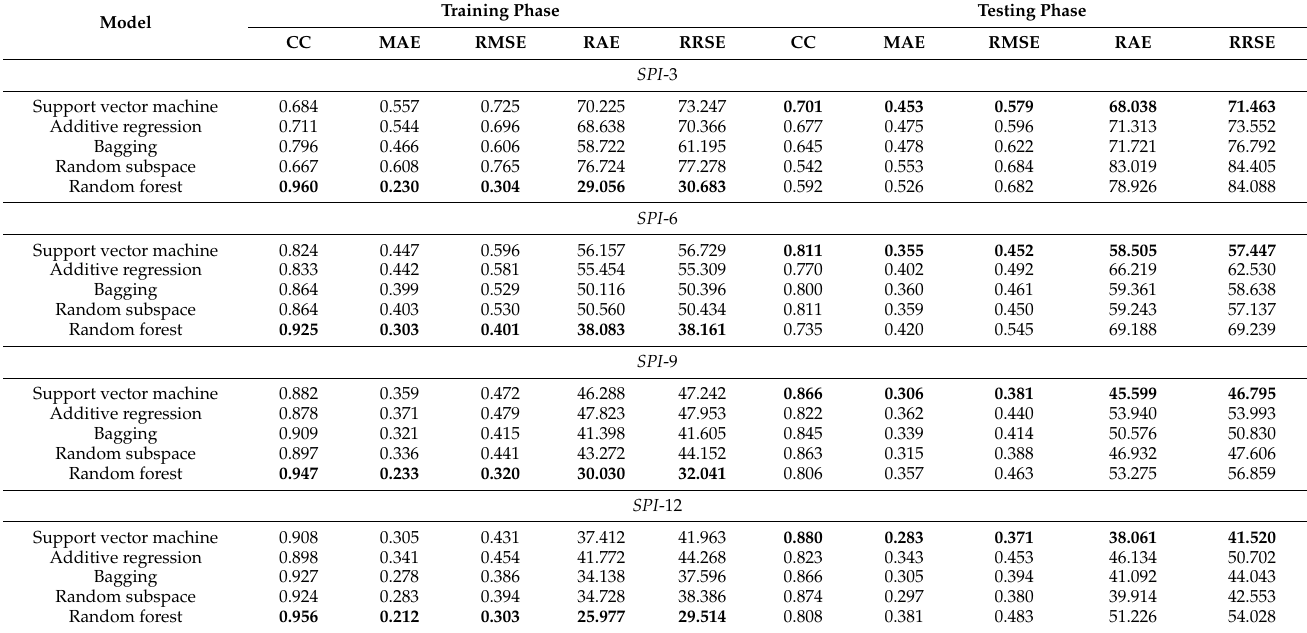
Table 5. Evaluation metrics of the model outputs for various timelines during the training and testing